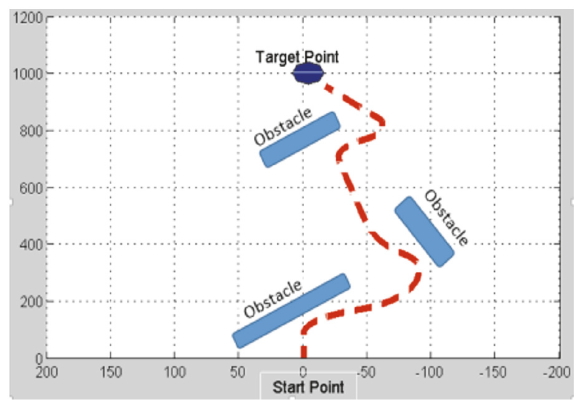
Figure 7: Khepera robot navigation in scattered environment with obstacles using ANFIS approach (source